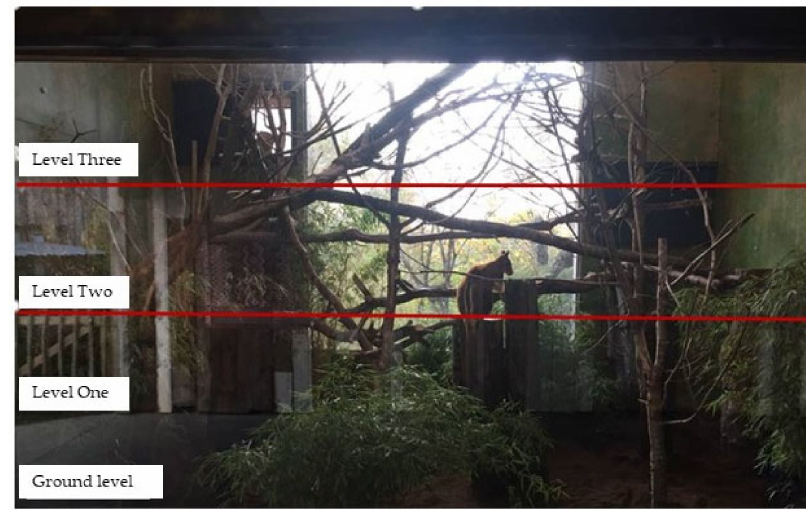
Figure A2. Image outlining pre-determined height levels used throughout data collection within the indoor habitat.